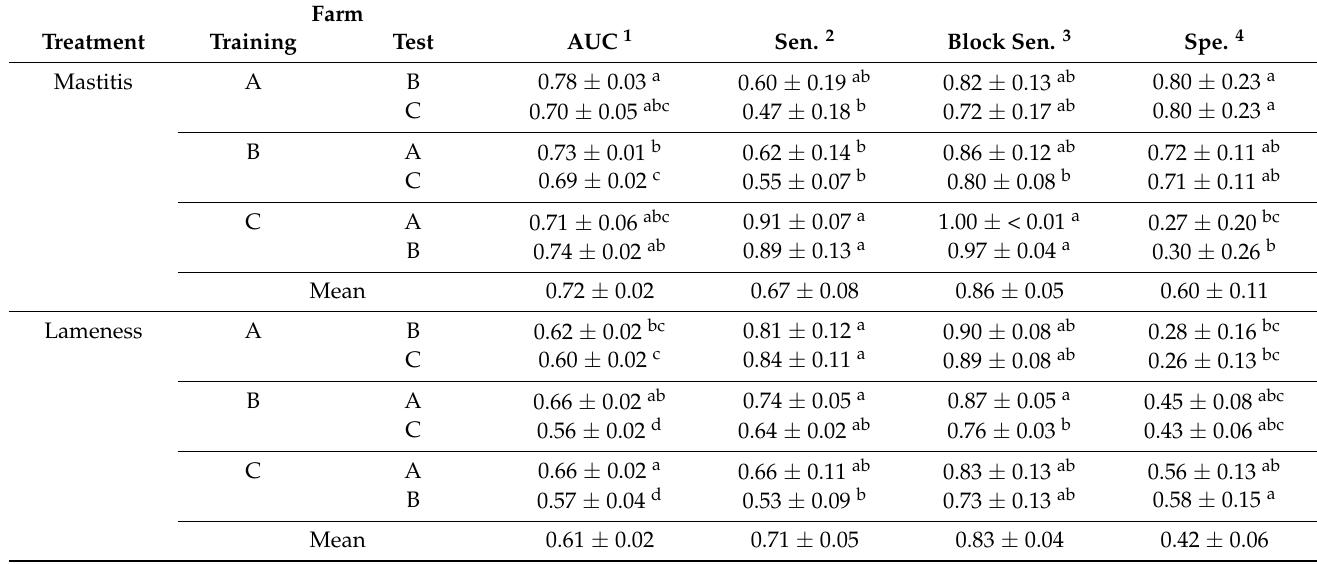
Table 3. Mean area under curve (AUC), sensitivity, block sensitivity, and specificity ( ± 95%-CI) for the classification of mastitis and lameness treatments of all cows. Models were trained on one farm and then tested on the two other respective